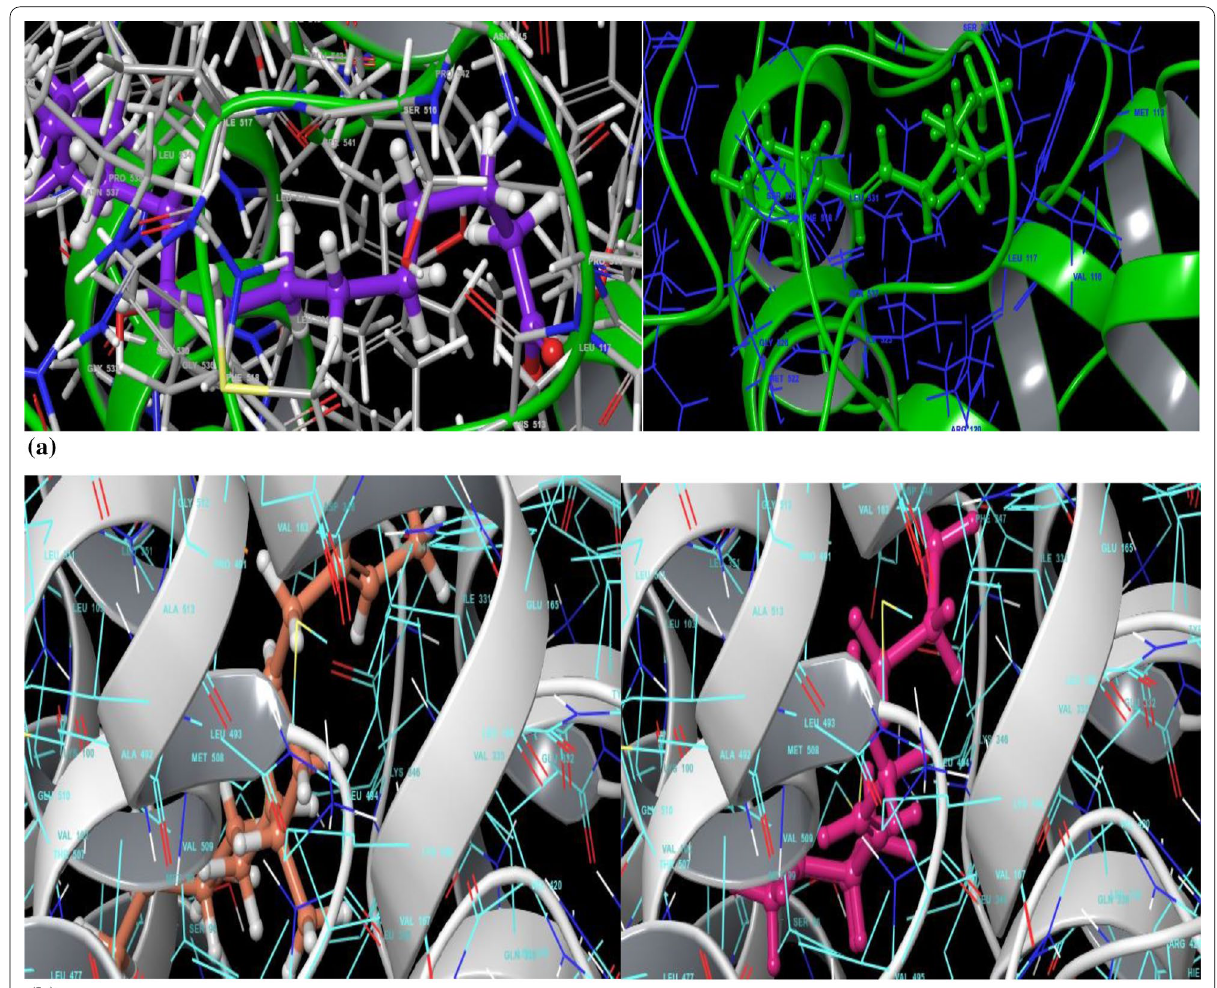
jorensis leaf. The extract at concentration of 200 µg/ml